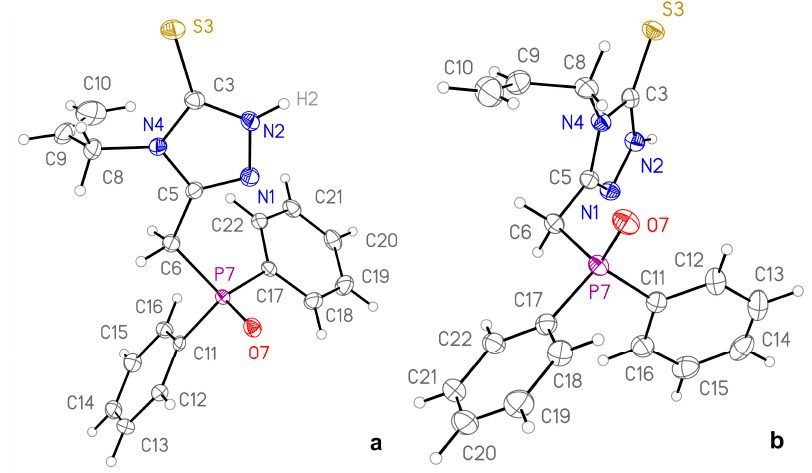
Figure 1. General view of molecule 1 in polymorphic modifications 1a ( a ) and 1b ( b ): anisotropic displacement parameters are drawn at 50% probability level. Table 2. Selected torsion angles (°) in conformers of 1 .